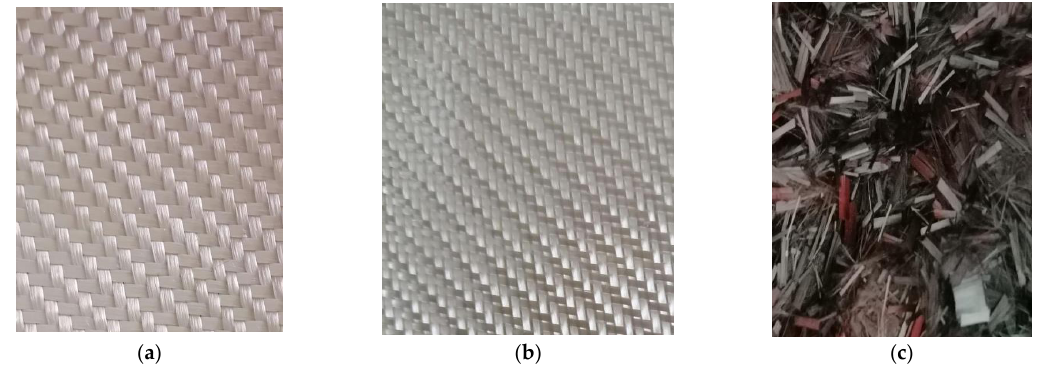
Figure 2. Fiber cloth: ( a ) Kevlar ® 49 twill fabric; ( b ) glass twill fabric; ( c ) chopped carbon fiber 0.6 cm. Polymers 2021 , 13 , x FOR PEER REVIEW